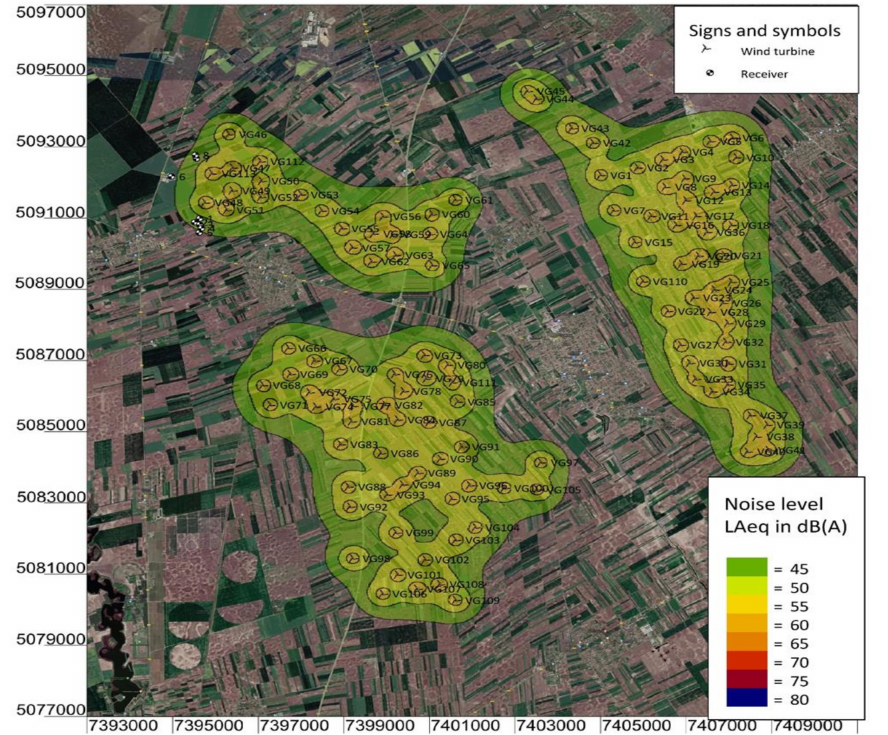
Figure 3. Results of modeling the spatial dispersion of noise for the night period (coordinates are given in the Gauss-Kruger